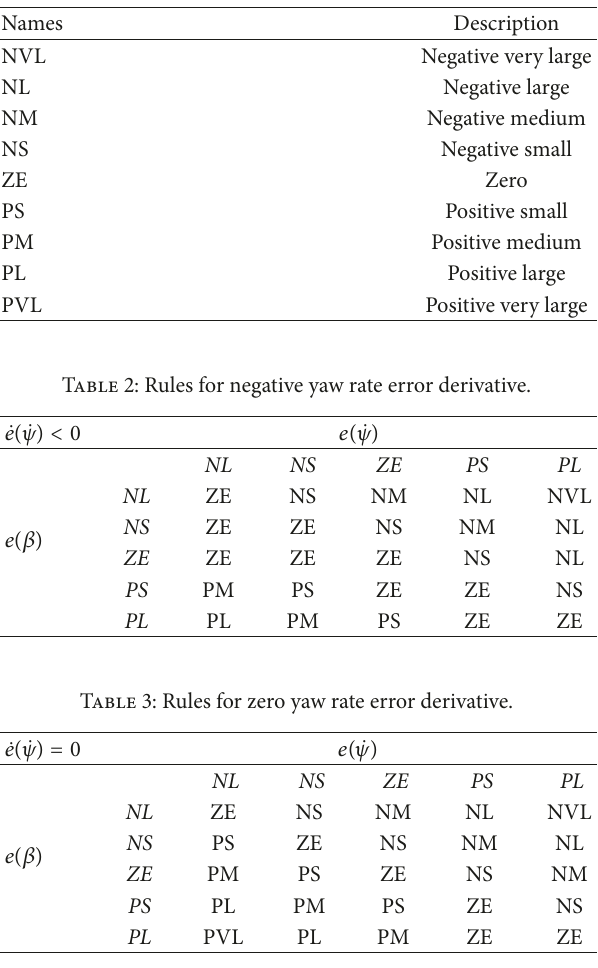
Table 1: Membership functions names.